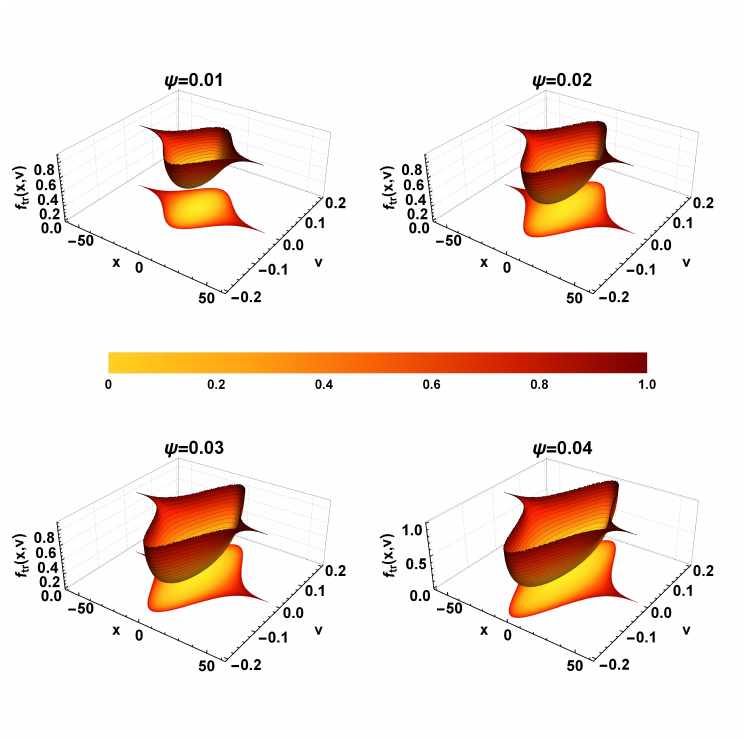
Figure 7. The trapped ion distribution function f tr ( x , v ) versus x and v , as well as 2D projection, for different values of ψ , and for fixed T r = 3 and δ = 40.